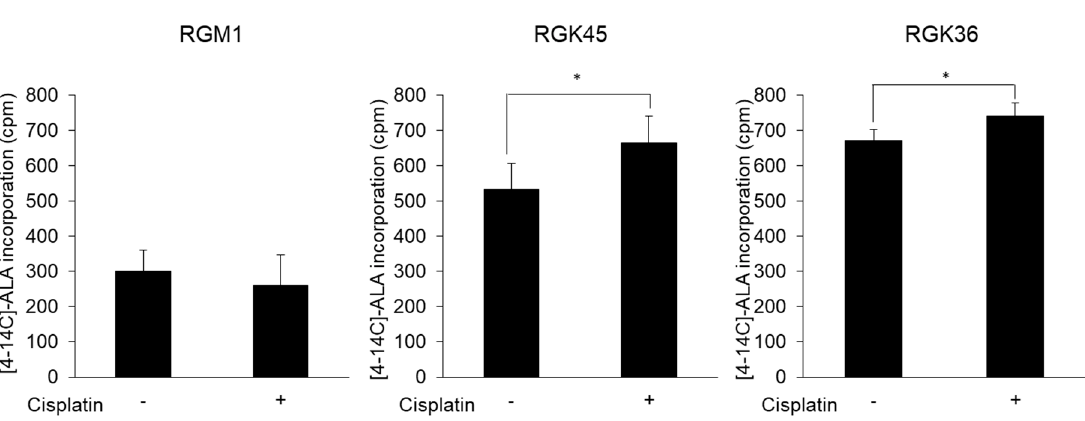
Figure 6. Cellular uptake of 14C-labeled ALA. ALA uptake increased specifically in cancer cells by cisplatin treatment (10 μ M). Data are expressed as means ± SD (n = 4). * p < 0.05.